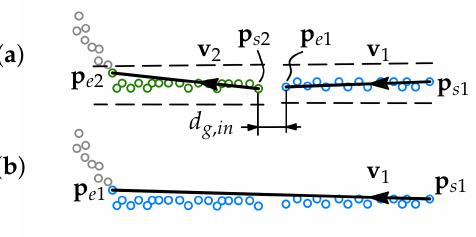
Figure 8. ( a ) Two segments 1 and 2 are found. The segments are divided since the gap d g , in > ¯ d g , in . ( b ) If the angle between v 1 and v 2 is less than the defined angle tolerance ¯ α 12 , then the two segments are merged.